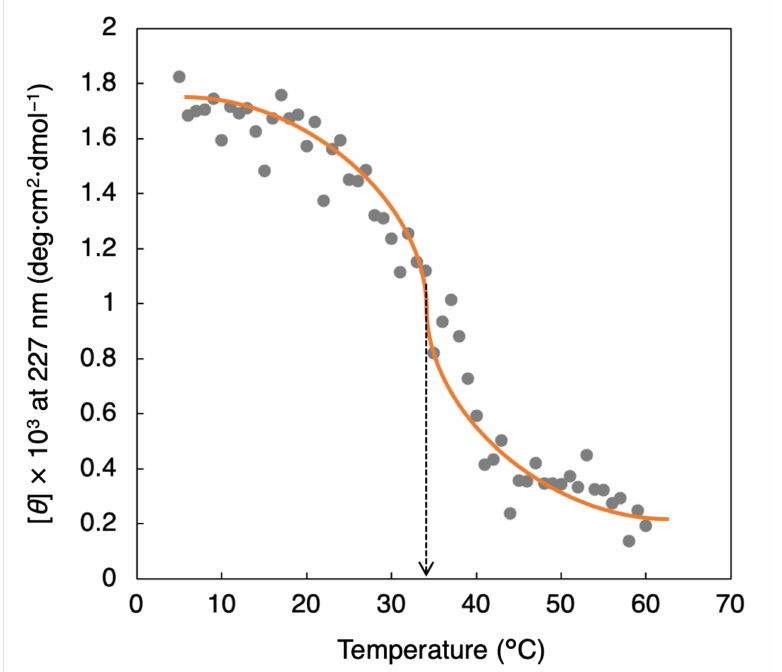
Figure 3. Maximal peak intensity of Azo-(PPG) 10 in the CD spectrum at different